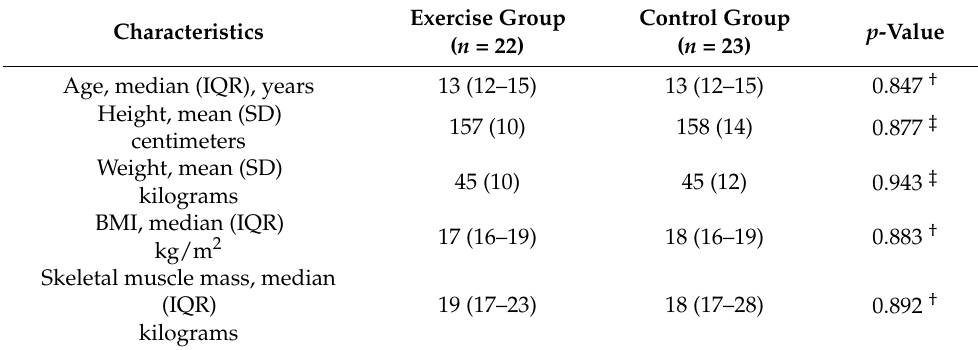
Table 2. Anthropometric characteristics of participants.